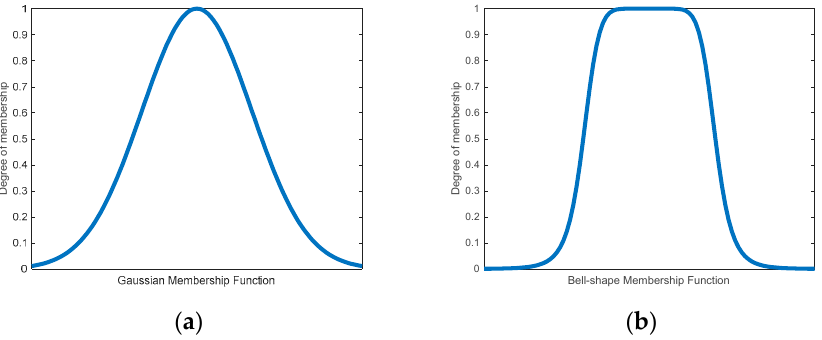
Figure 19. Degree of membership ( a ) Gaussian ( b ) Bell-shape.